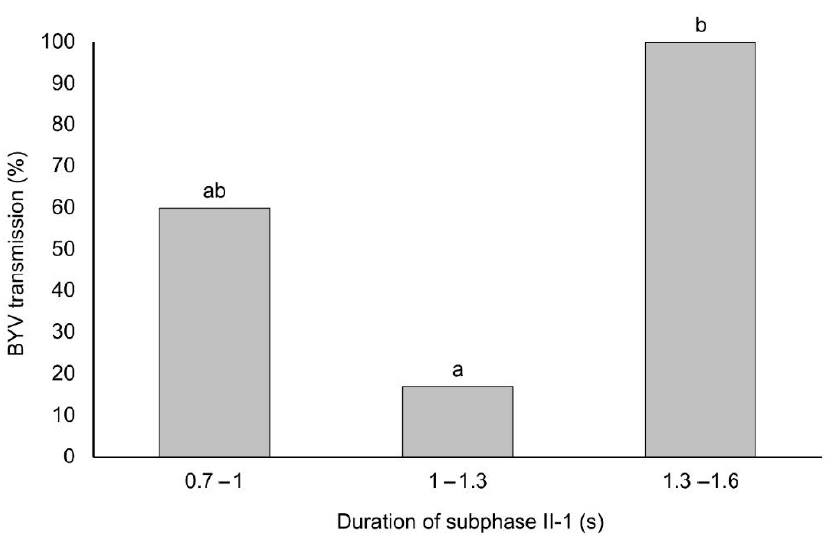
Figure 3. Transmission efficiency of BYV at different durations of subphase II-1 of the phloem-pd. EPG recording interrupted during the subphase II-1 were split and grouped according to intervals of 0.3 s: 0.7 to 1; 1 to 1.3; 1.3 to 1.6 s ( X -axis). BYV transmission efficiency at each specific duration of subphase II-1 is also represented ( Y -axis). Different letters show significant differences according to a Student’s t test ( p < 0.05).